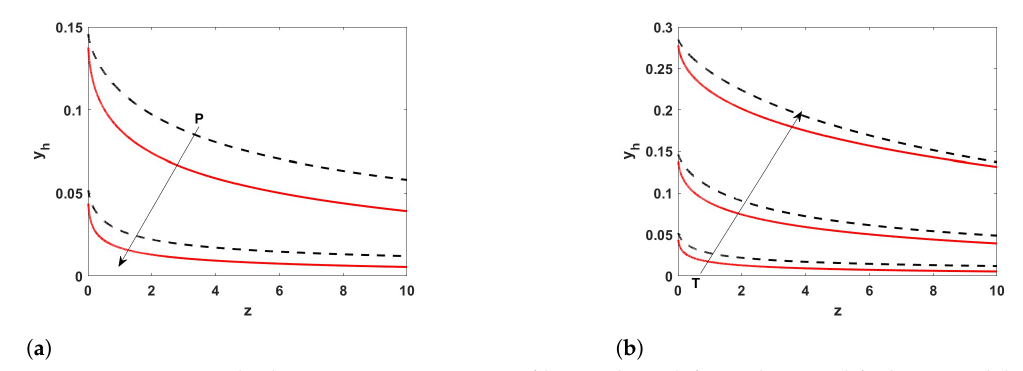
Figure 3. Average hydrogen concentration profiles evaluated from the simplified 2D model (Equation (31), solid red curves) and from the 1D model (Equation (35a–c), dashed black curves) at Pe = 100, and ( a ) T = 500 ◦ C at 1 and 10 bar; ( b ) P = 10 bar at 500, 600, and 700 ◦ C.